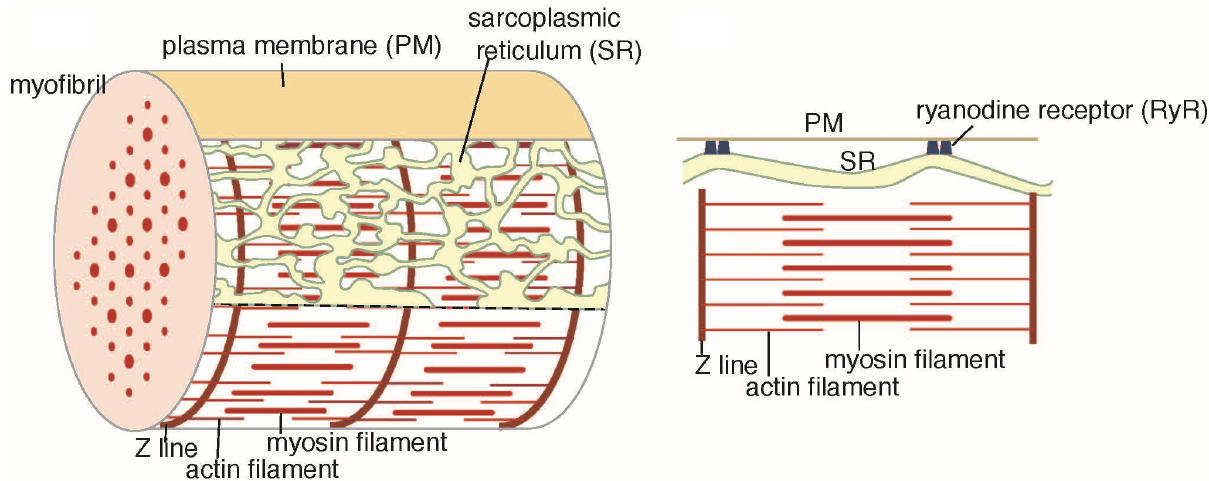
Figure 1. Diagram of a cross-striated adductor muscle cell of scallop in the resting state. The illus- trations are based on the data of Castellani et al. (1989) [8], Sanger and Sanger (1985) [9], Loesser et al. (1992) [16] and Quinn et al. (1998) [17]. An illustration of the feet-like structure of the vertebrate cross-striated muscle can be found in [18].